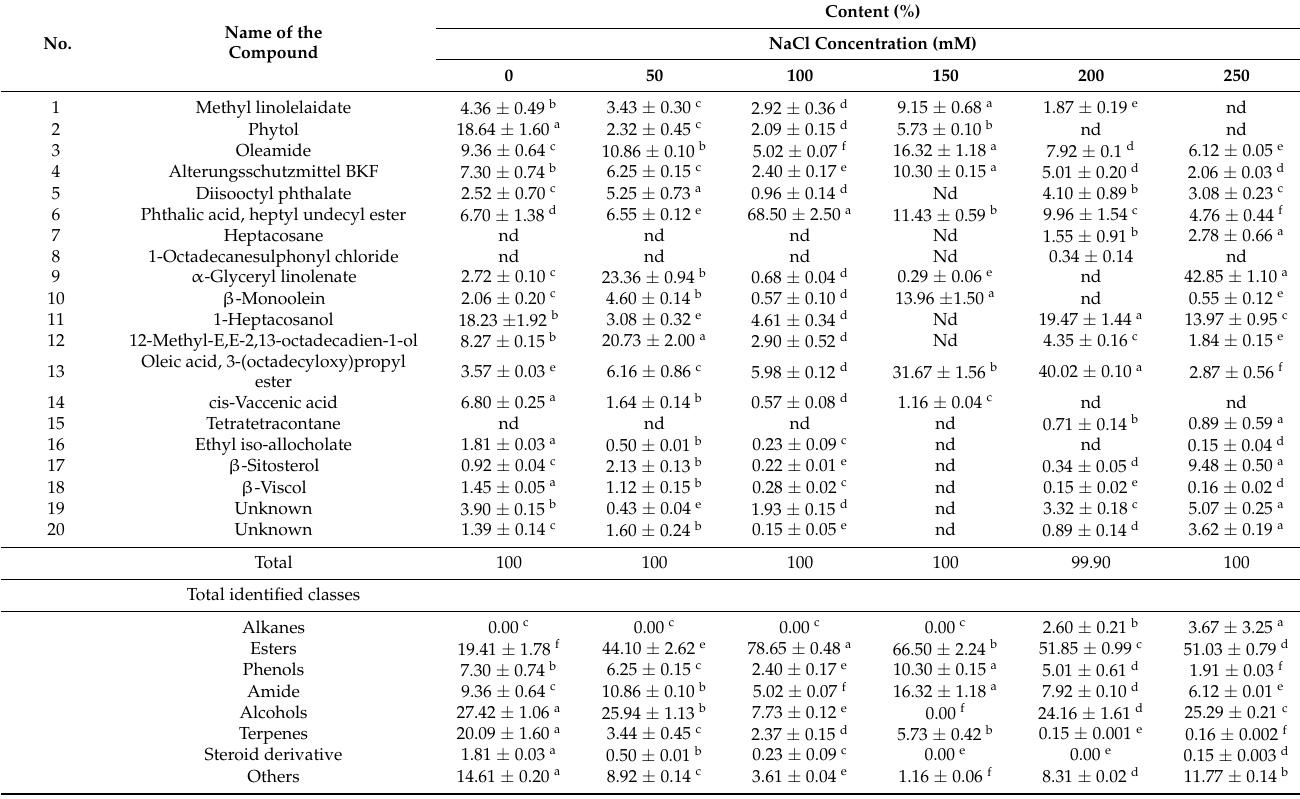
Table 2. Changes in the compositions and relative percentages (%) of volatile compounds in the leaves of H. cannabinus under different NaCl concentrations (0, 50, 100, 150, 200, and 250 mM). The results, reported as percentages, are means ± SD ( n = 3). According to the Duncan test ( p < 0.05), different letters within a row differ significantly; nd, not